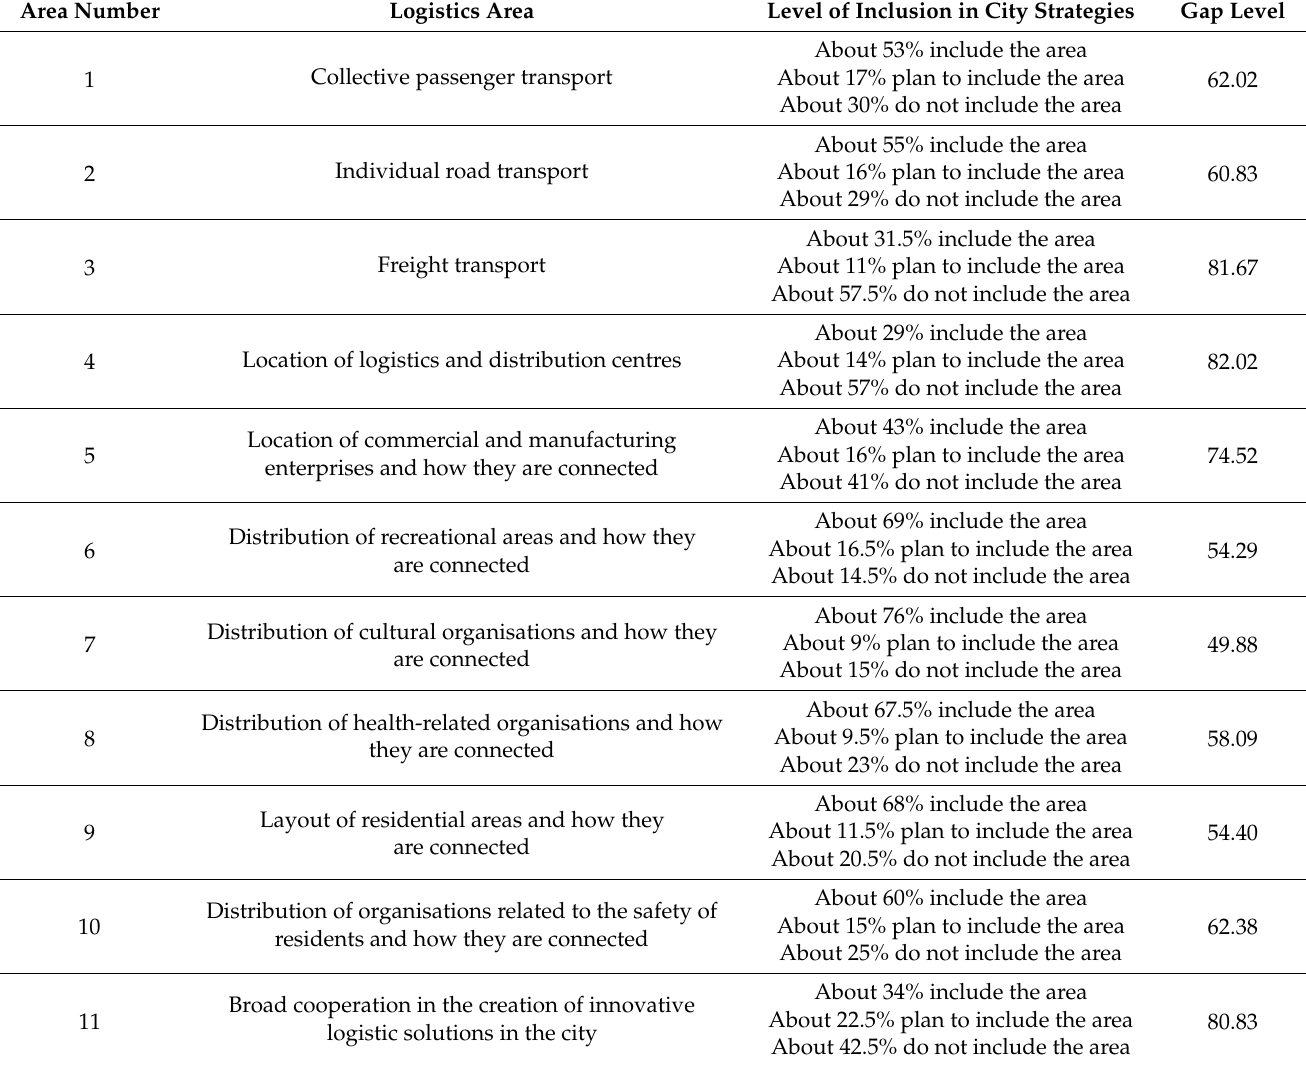
Table 3. Gaps in logistic problems in Polish